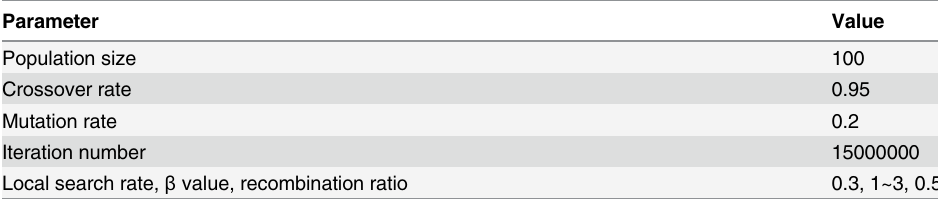
Table 6. Algorithm parameters